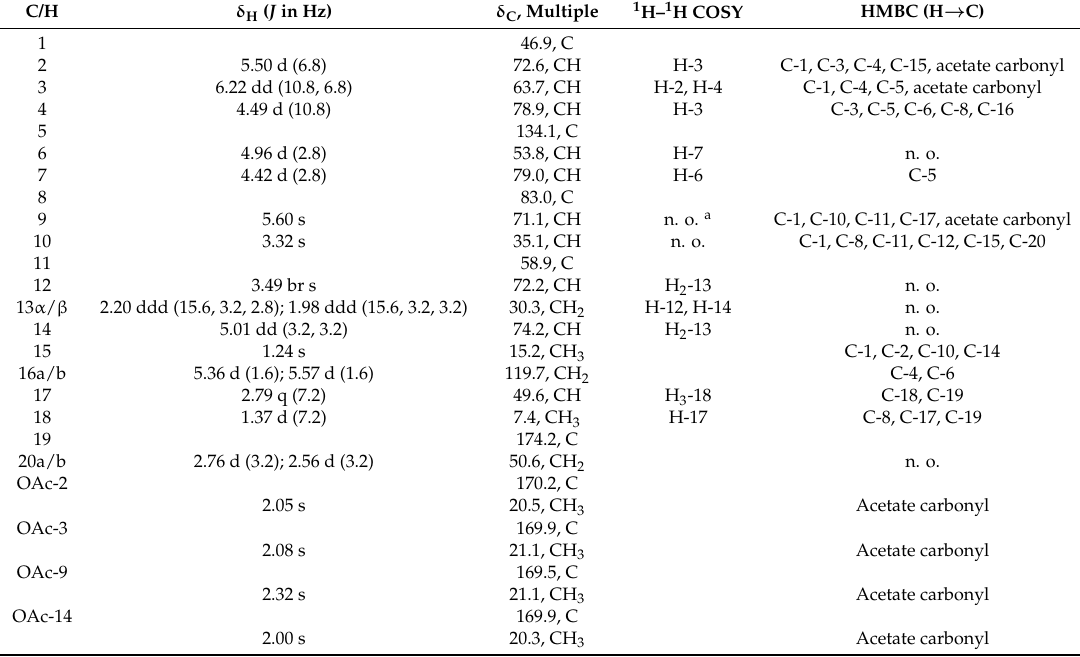
Table 1. 1 H (400 MHz, CDCl 3 ) and 13 C (100 MHz, CDCl 3 ) NMR data, 1 H– 1 H COSY, and HMBC correlations for briarane 1